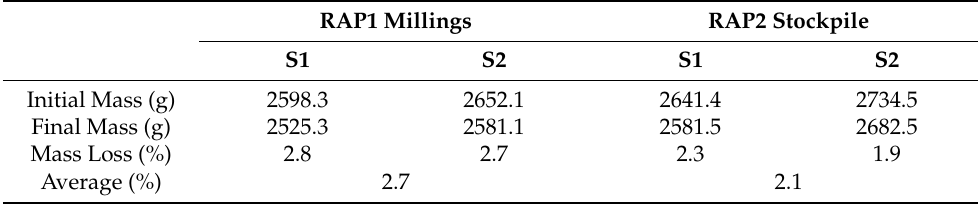
Table 6. Summary of raveling test results.